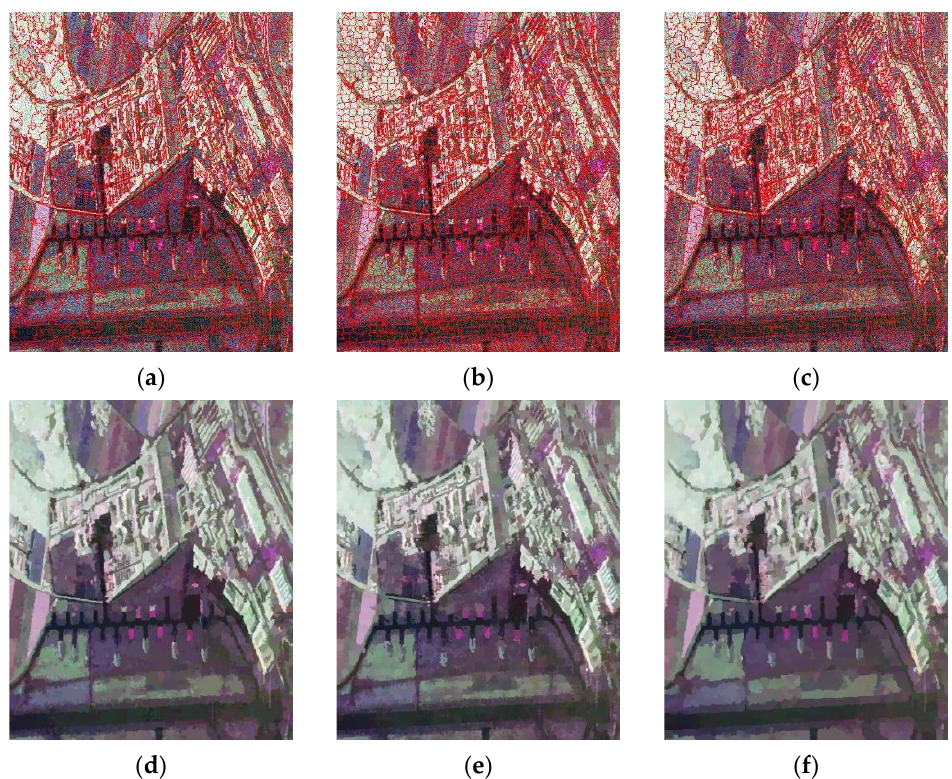
Figure 5. Segmentation results of ESAR data using the proposed method, the Pol-SLIC and Pol-ERM, respectively. The first row of images ( a – c ) shows the edges of superpixels. The second row of images ( d – f ) shows the representation maps (Pauli RGB images) of the segmentation results.